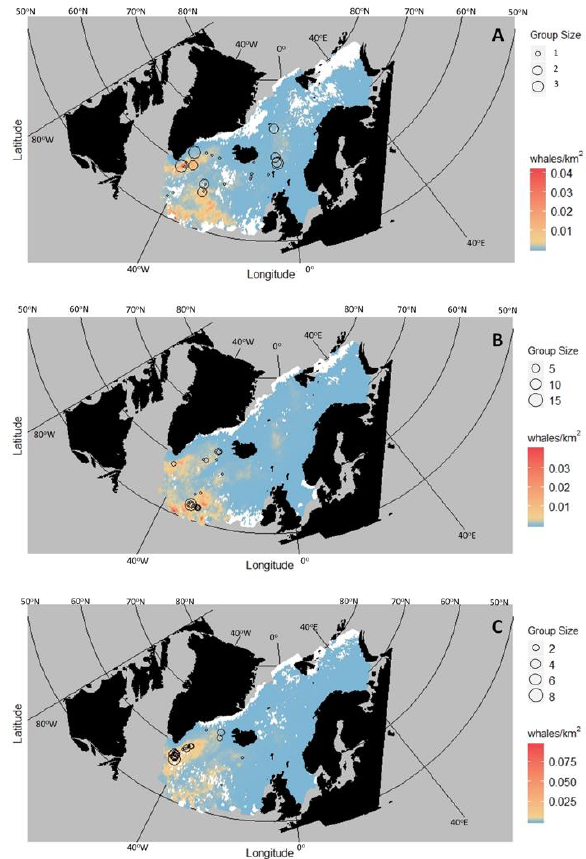
Figure 7. Prediction map of sei whale distribution, based on the full model, using environmental covariate values from the years 2001, 2007 and 2015 (panels A-C, respectively). Red is the highest density. White shows areas outside predictive space. In all panels the circles show the observed sightings of sei whale groups from the specified years, with size scaled to number of individuals in each group.